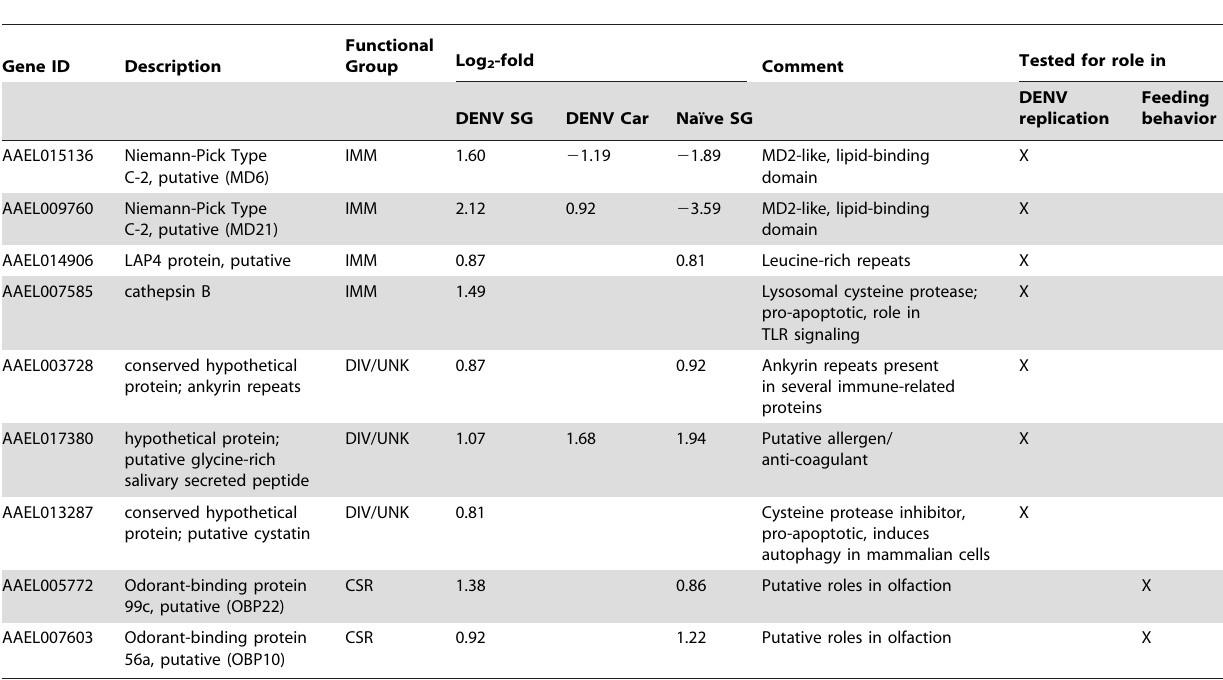
Table 1. Candidate genes selected for functional testing via RNAi-mediated gene knockdown.